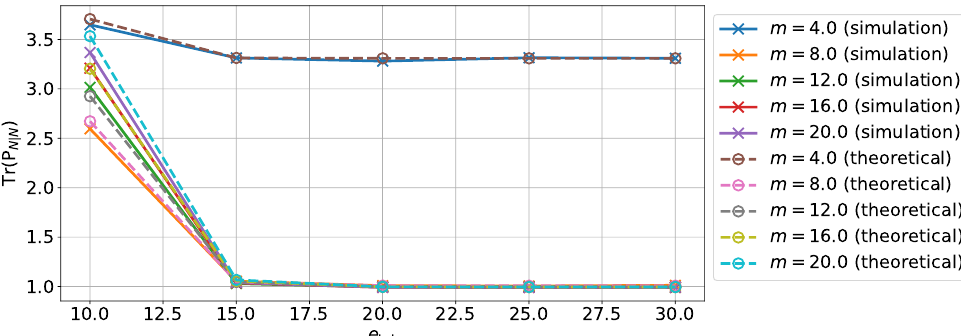
Figure 4. Theoretical and simulated variance of estimation error on the position depending on the energy supplied to each variable using an unreliable memory for different numbers of bits in the representation m in the case of the large-size